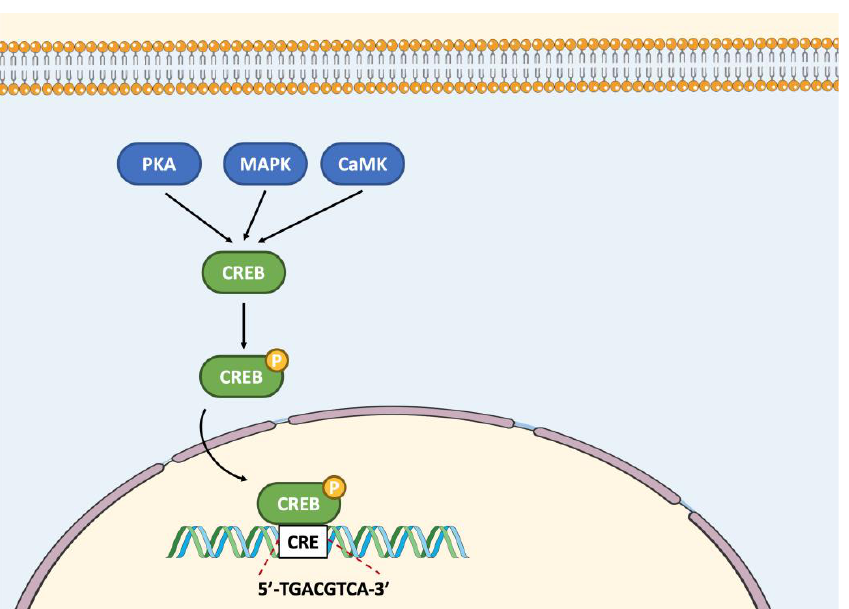
Figure 2. Regulation of the activity of CREB-like subfamily members by phosphorylation, followed by recruitment to the CRE DNA regulatory element. Abbreviations: CaMK, Ca 2+ /calmodulin dependent protein kinase; CRE, cyclic AMP response element; CREB, cAMP responsive element binding protein; MAPK, mitogen activated protein kinase; P, phosphate; PKA, protein kinase